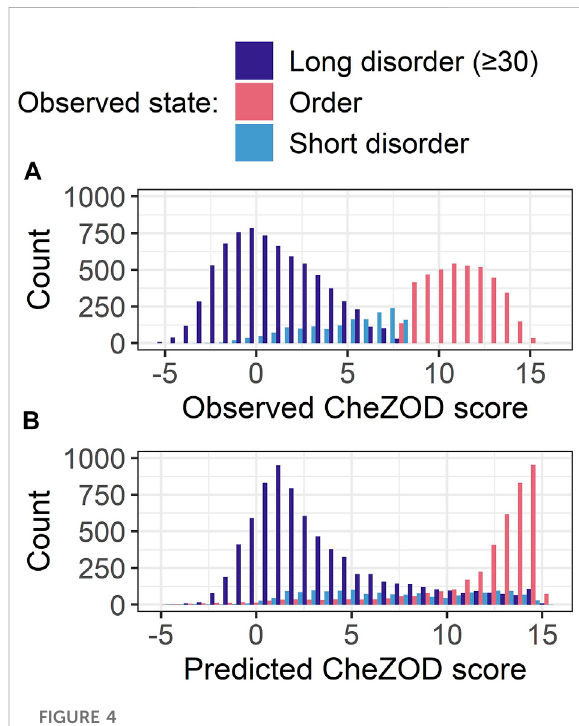
FIGURE 4 Data: set CheZOD117 (Dass et al., 2020). All residues in CheZOD117 were classi fi ed into one of three classes: ordered (chemical shift Z-score (CheZOD score) > 8), short disorder and long disorder (disordered residues (CheZOD score ≤ 8) in a disordered region ≥ 30), using the ground truth labels. (A) Distribution of the observed CheZOD scores (i.e., the ground truth labels) in the three classes. (B) Distribution of SETH ’ s predicted CheZOD scores in the three classes. SETH is a CNN trained on continuous chemical shift Z-scores and outperformed all state- of-the-art methods evaluated, as well as all our other